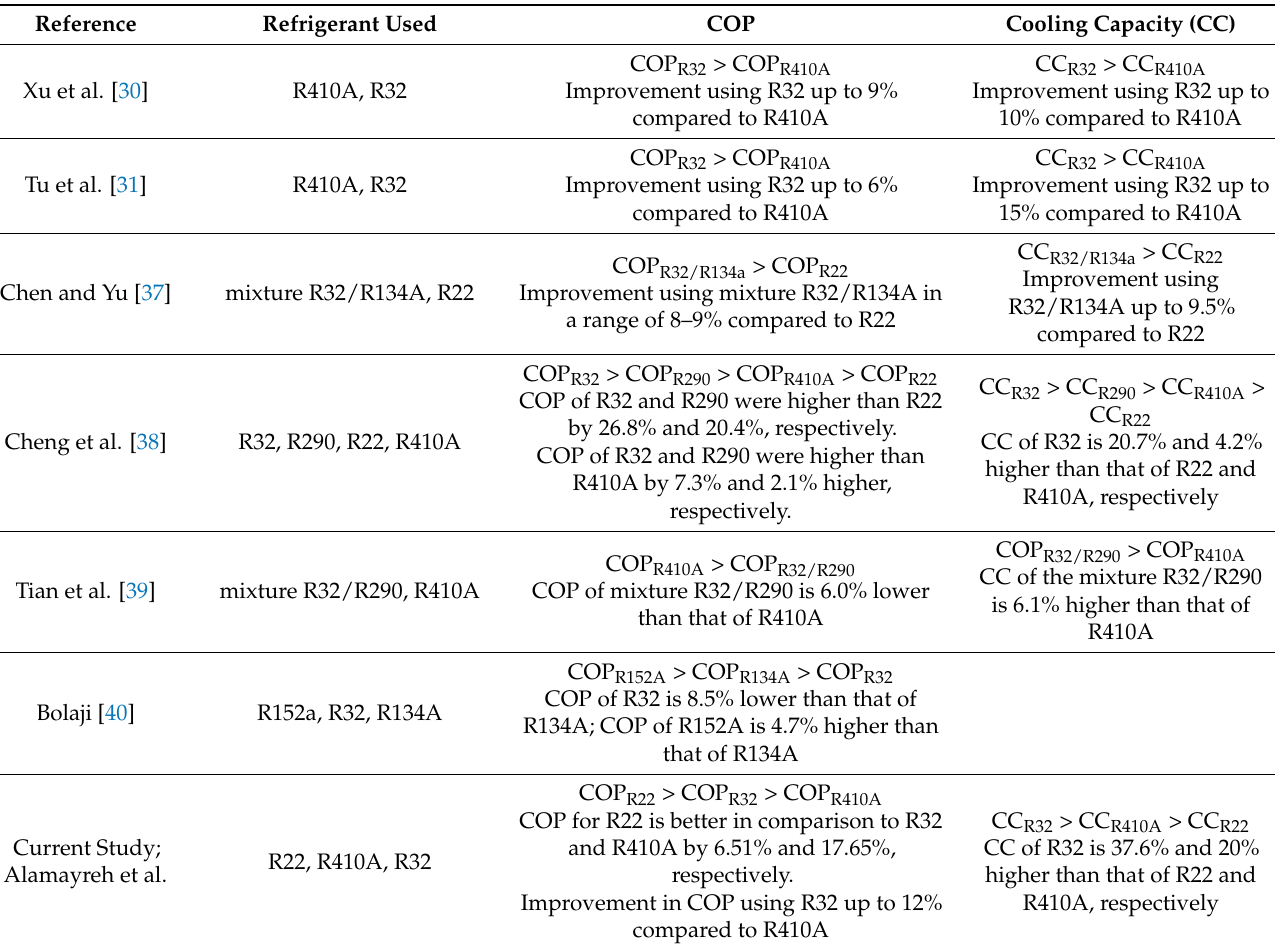
Figure 6. The effect of refrigerant mass flow rate on the evaporative temperature at constant condenser temperature 60 °C. Table 7. Comparison of current work of alternative refrigerants with other researcher’s work reported in the literature